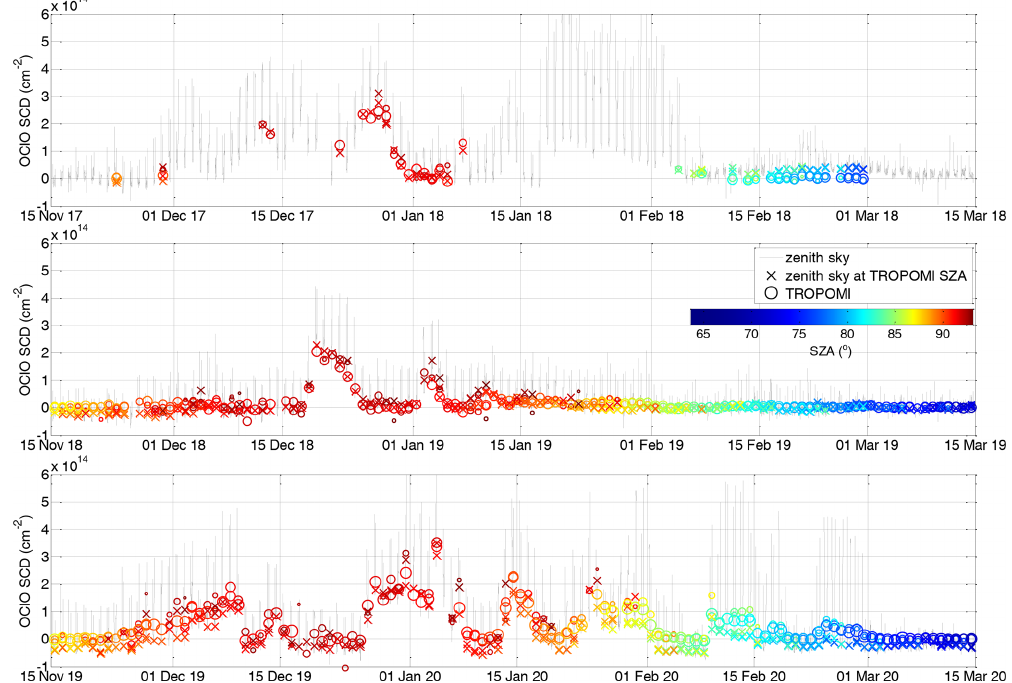
Figure C1. Same as Fig. 4 but comparison with ground-based OClO SCDs at Kiruna retrieved with Ring spectra at a single temperature and without the OClO × λ term in the DOAS